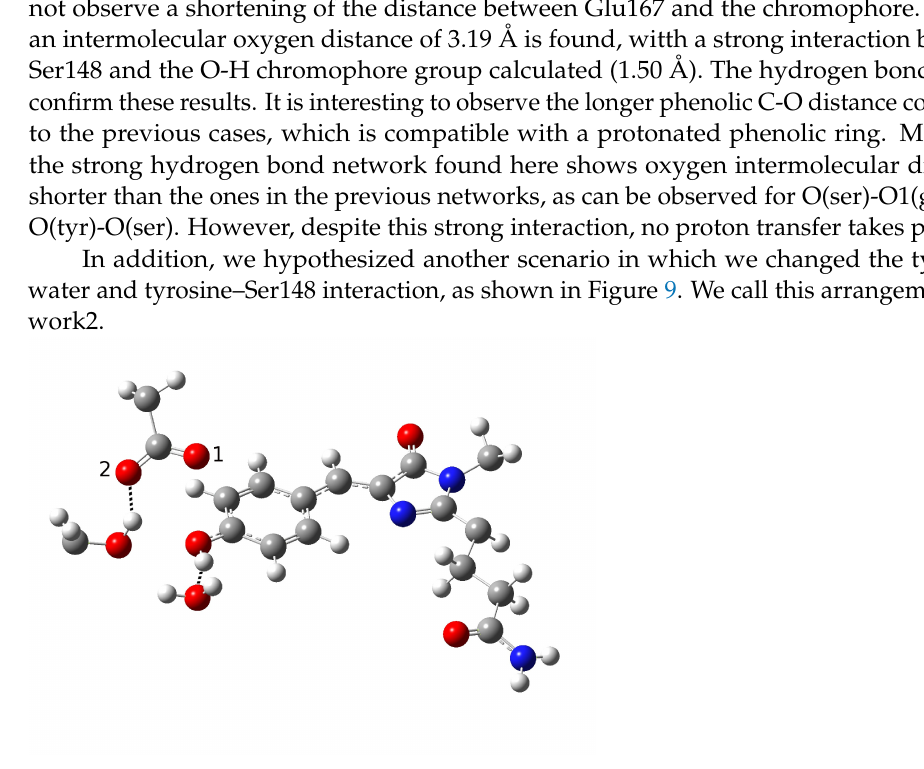
Figure 9. Second hydrogen bond network in psamFP488 (Network2) proposed as the neutral form leading to